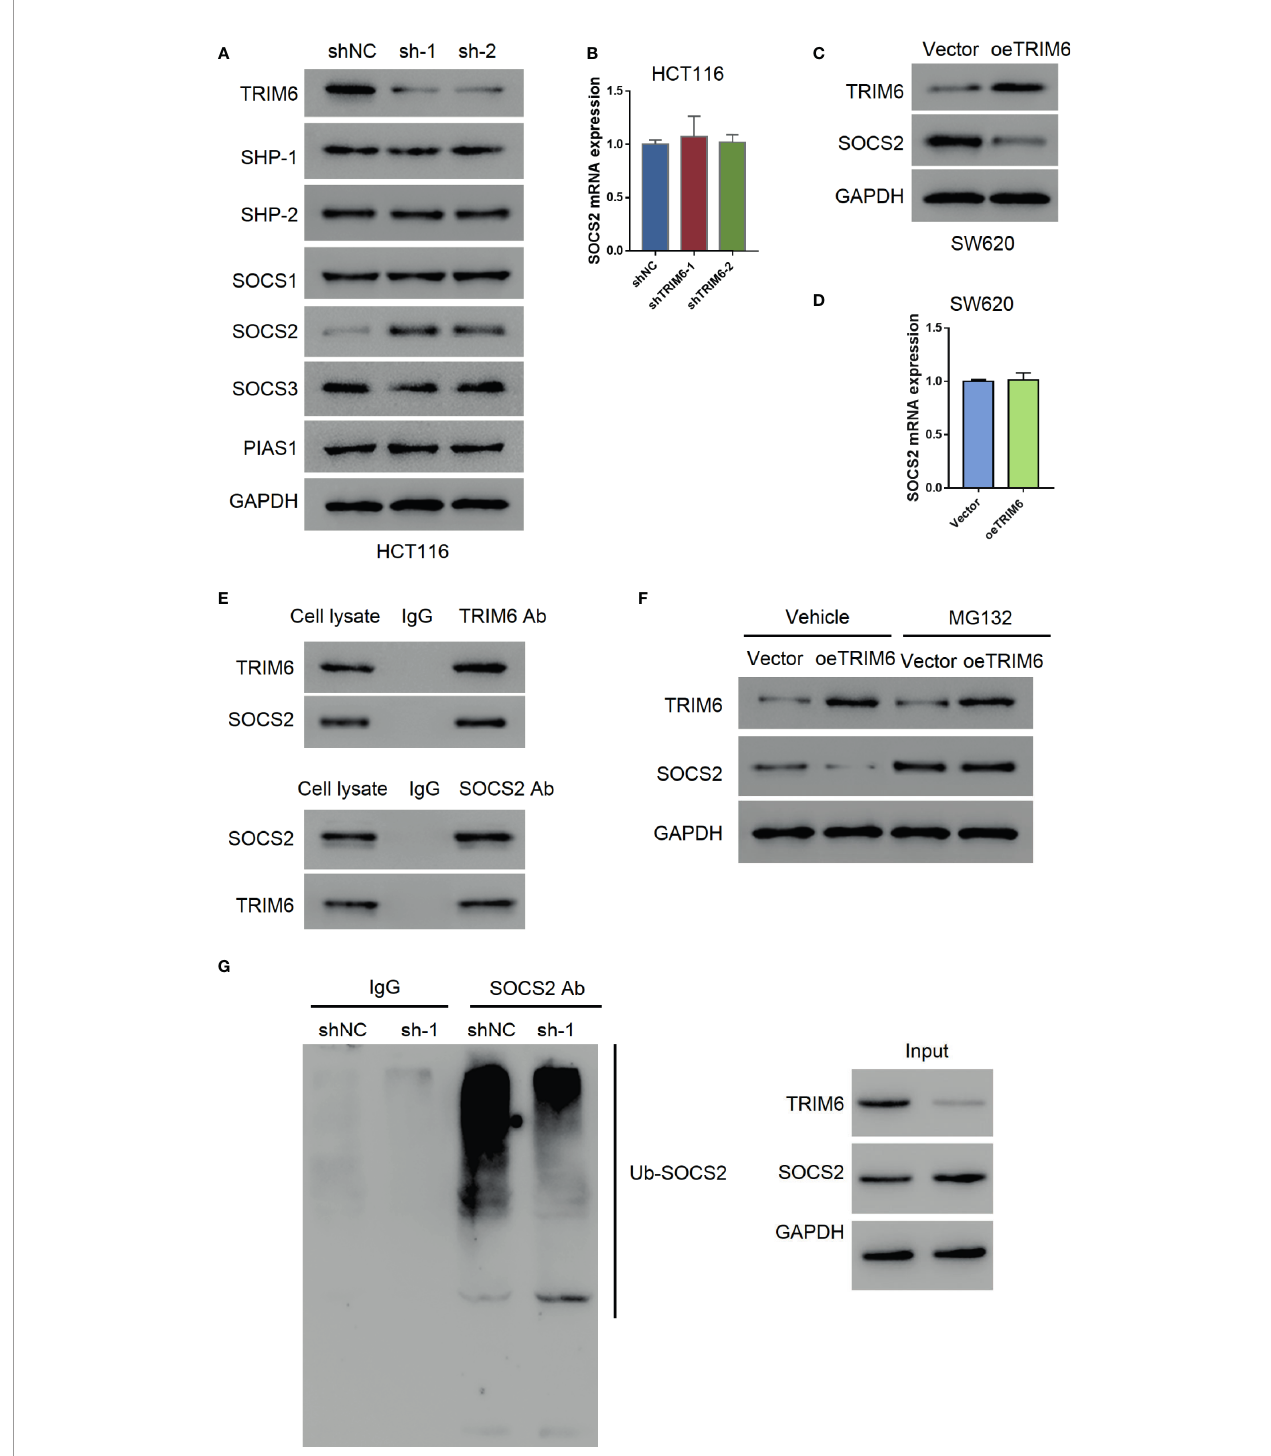
FIGURE 4 | TRIM6 may promote STAT3 phosphorylation via SOCS2. (A) Protein expression of STAT3 phosphatases (SHP-1, SHP-2), SOCS1, SOCS2, SOCS3, and PIAS1 in TRIM6 knockdown HCT116 cells. (B) SOCS2 mRNA expression level measured via qRT-PCR in TRIM6 knockdown HCT116 cells. SOCS2 protein (C) and mRNA expression levels (D) in TRIM6-overexpressed SW620 cells detected via Western blot and qRT-PCR, respectively. (E) CO-IP analysis between TRIM6 and SOCS2. (F) TRIM6 and SOCS2 expression levels in TRIM6-overexpressed SW620 cells with/without MG132 treatment. (G) IP analysis of SOCS2 ubiquitination in TRIM6 knockdown HCT116 cells. The results are from at least three separate